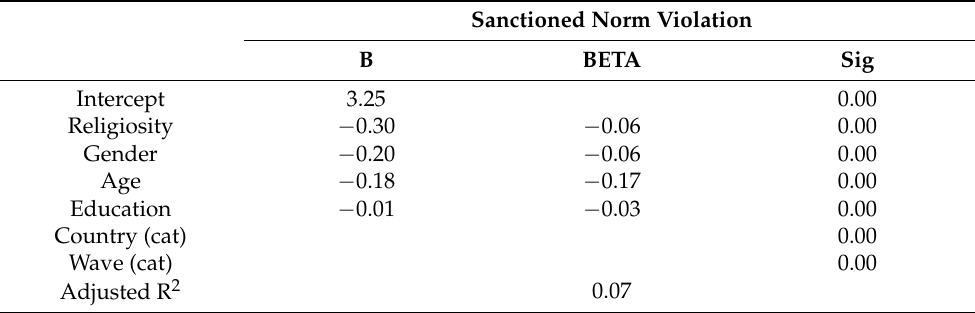
Table 1. OLS regression on Sanctioned norm violation and Defence of life. All countries included. A more detailed table is available in the Supplementary